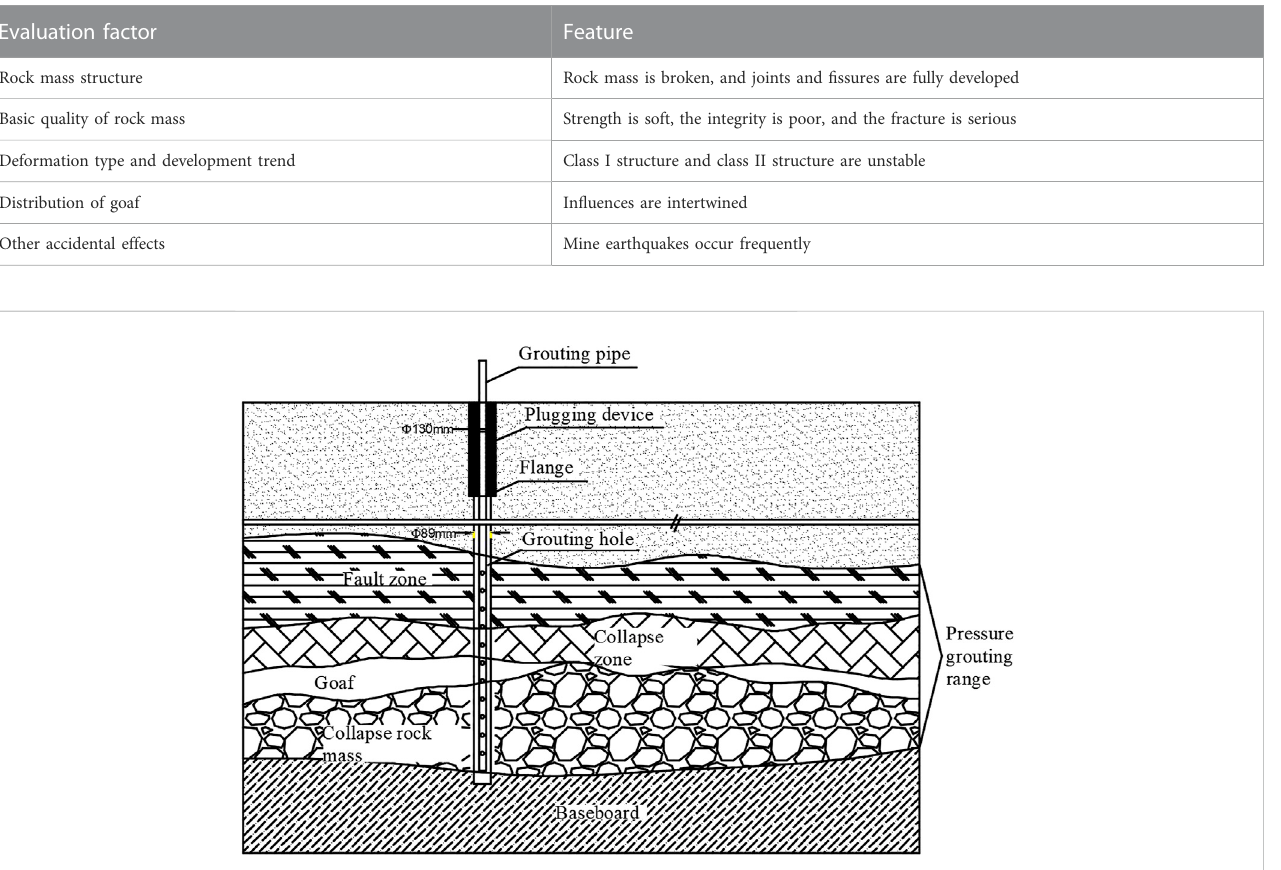
TABLE 2 Features of the goaf foundation.